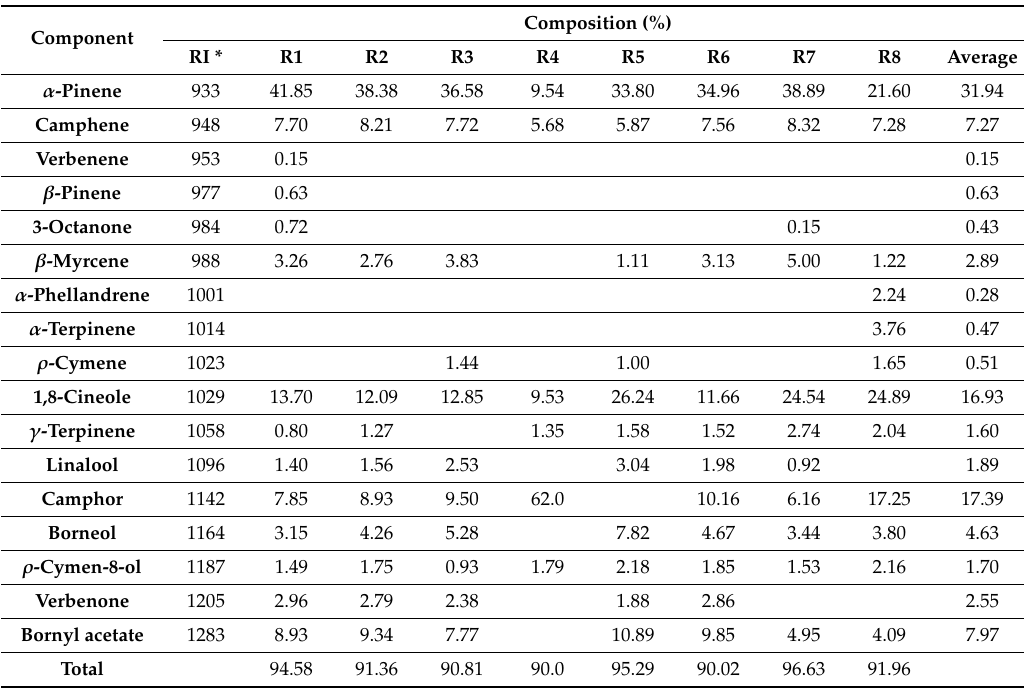
Table 2. The chemical composition (%) of the EO from the R. o ffi cinalis